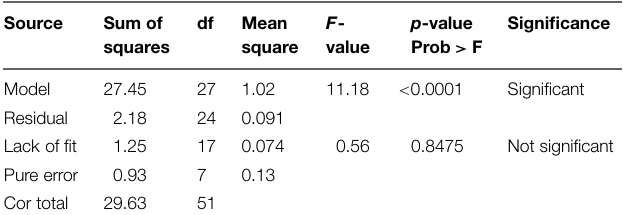
TABLE 3 | Analysis of variance (ANOVA) of quadratic polynomial model and significance